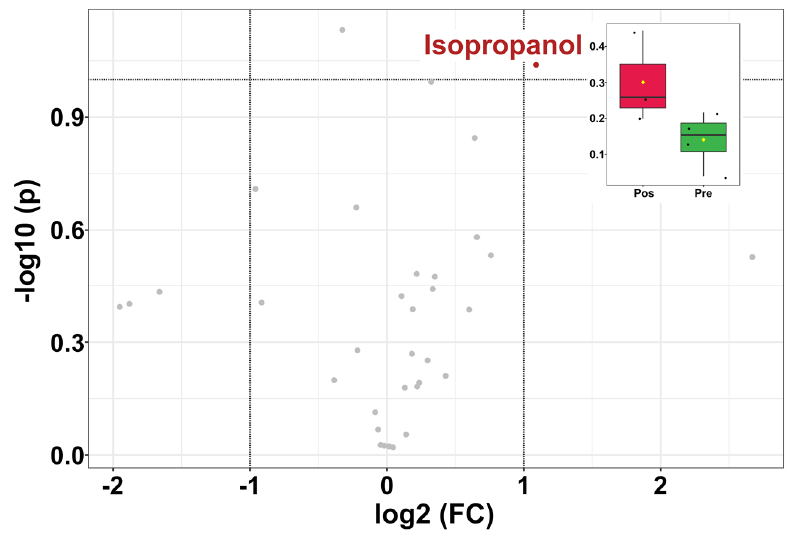
Figure 6. Volcano plot based on the comparisons between the concentrations of molecules in giant panda seminal plasma from the PRE and POST estrus groups. The right upper part shows the comparison for isopropanol.